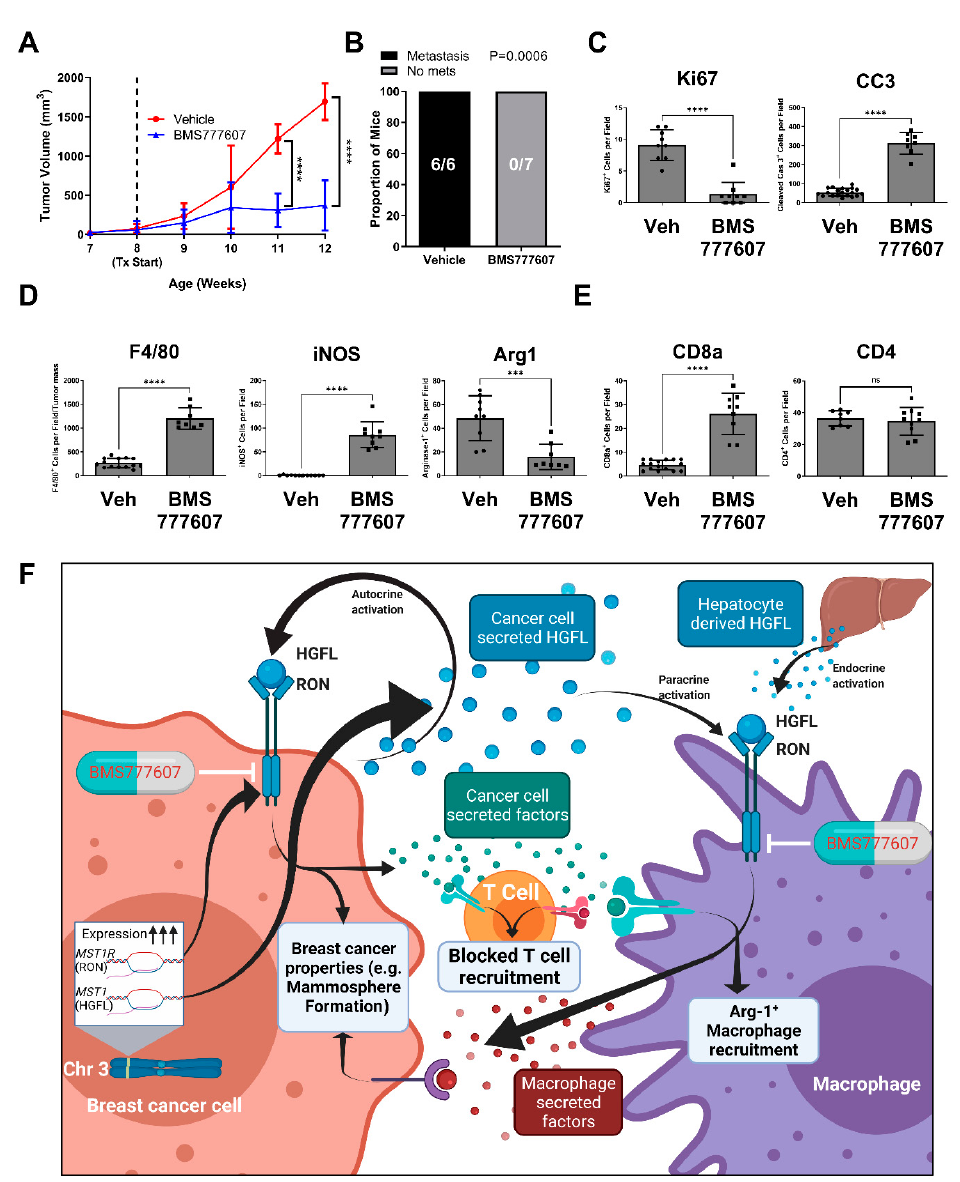
Figure 5. Pharmacological inhibition of HGFL-RON signaling via BMS777607 treatment abrogates PyMT-driven tumorigenesis and metastasis. ( A ) Tumor growth kinetics of mammary tumors in PyMT+ mice treated with 50 mg/kg/day BMS777607 versus vehicle control (Vehicle: n = 6; BMS777607: n = 7). Data was analyzed with a two-way ANOVA with Holm-Šídák post hoc tests. ( B ) Metastatic incidence in PyMT+ mice from ( A ) with BMS777607 treatment versus vehicle control. Data was analyzed using Fisher’s exact test. ( C ) Histological analysis of BMS777607 treated and vehicle-treated PyMT tumor sections stained with Ki67, CC3, ( D ) F4/80, iNOS, Arginase 1, ( E ) CD8a, or CD4. ( F ) Working model of our experimental findings summarized (generated using BioRender). *** p < 0.001; **** p < 0.0001; ns, not significant.